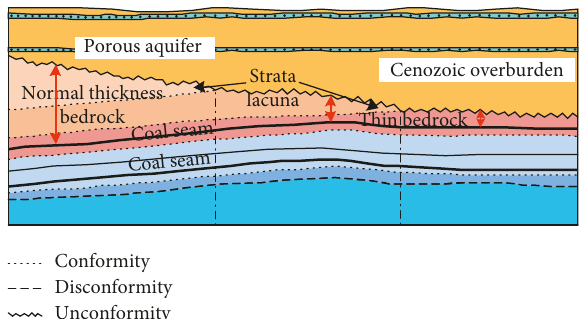
Figure 3: Hydrogeological profile of thin